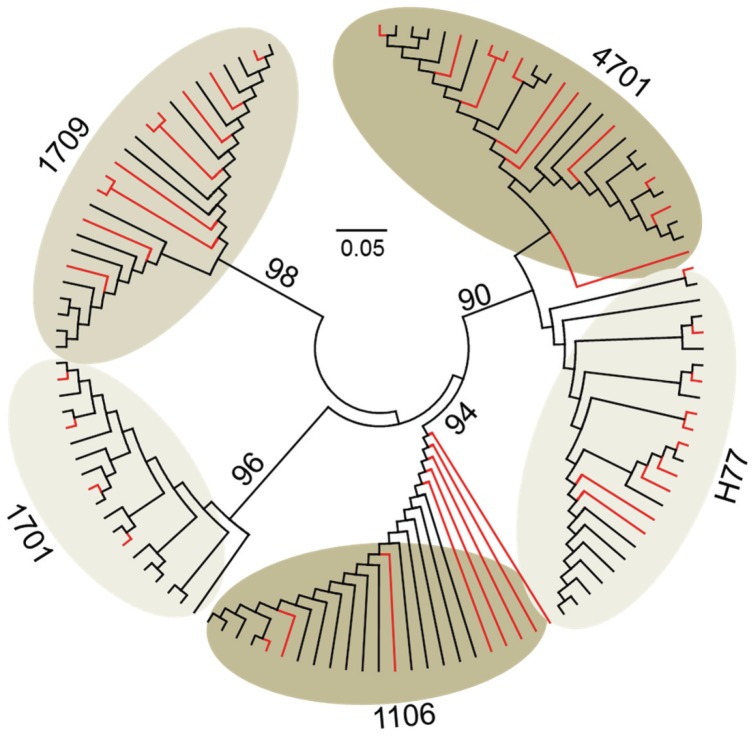
Neighbor-joining tree of HCV HVR1 variants recovered by either 454 sequencing (red) or cloning/Sanger sequencing (black) in five patient samples.The tree was constructed under maximum composition likelihood model with bootstrap support (percentage) shown on major branches.